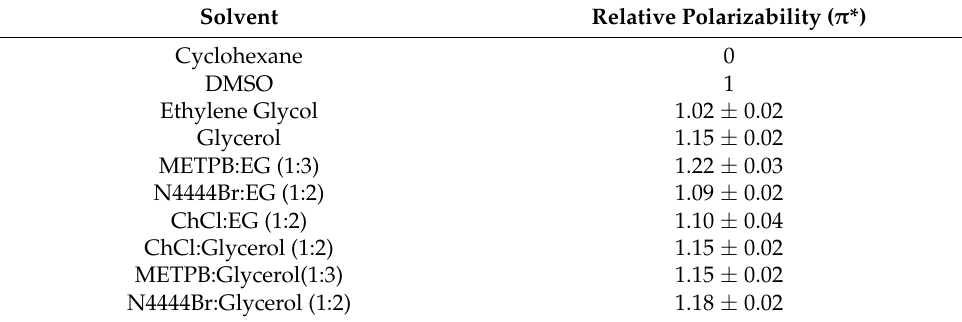
Table 2. Polarizability of DES and Reference